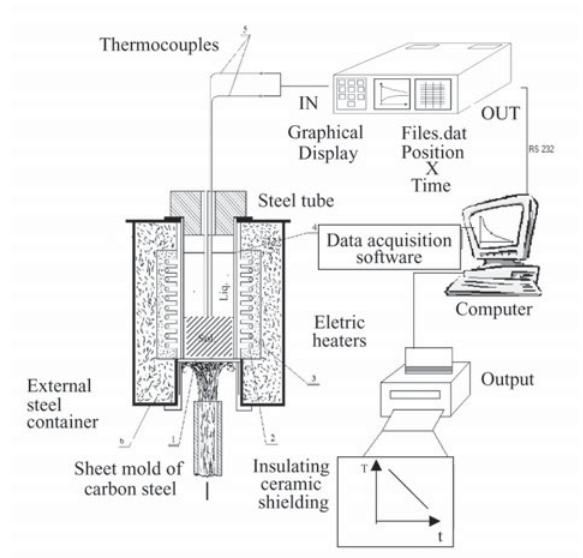
Figure 1. Experimental set-up used in unidirectional solidifica- tion